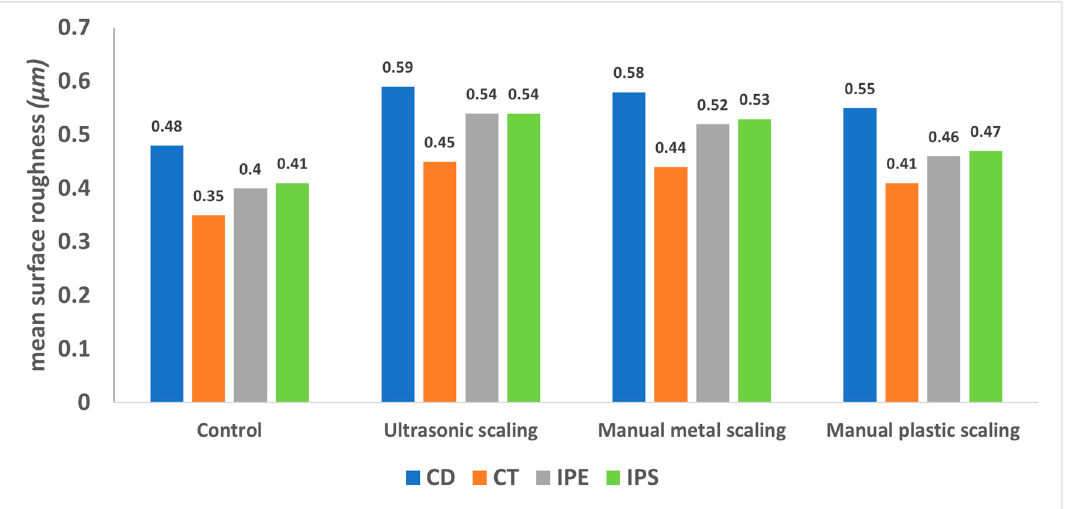
Figure 2. Surface roughness of the studied ceramic compositions. CD; zirconia-reinforced lithium silicate (Celtra Duo). CT; advanced lithium disilicate (CEREC Tessera). IPE; lithium disilicate (IPS Emax CAD). IPS; leucite-reinforced (IPS Empress CAD).